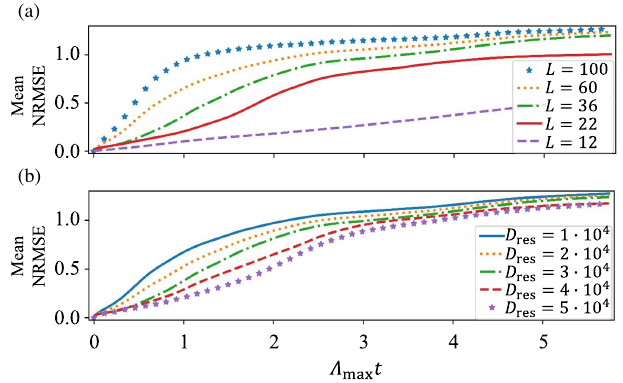
FIG. 5. (a) The mean NRMSE in the predictions of the KS system as a function of time using the same optical network as in Figs. 3 and 4 but for different system sizes L ¼ 12 , 22, 36, 60, and 100. (b) For the case of L ¼ 60 , we observe improvement of the prediction performance as the number of photonic nodes in 10 4 to D 5 × 10 4 reservoir increases from D res ¼ res ¼